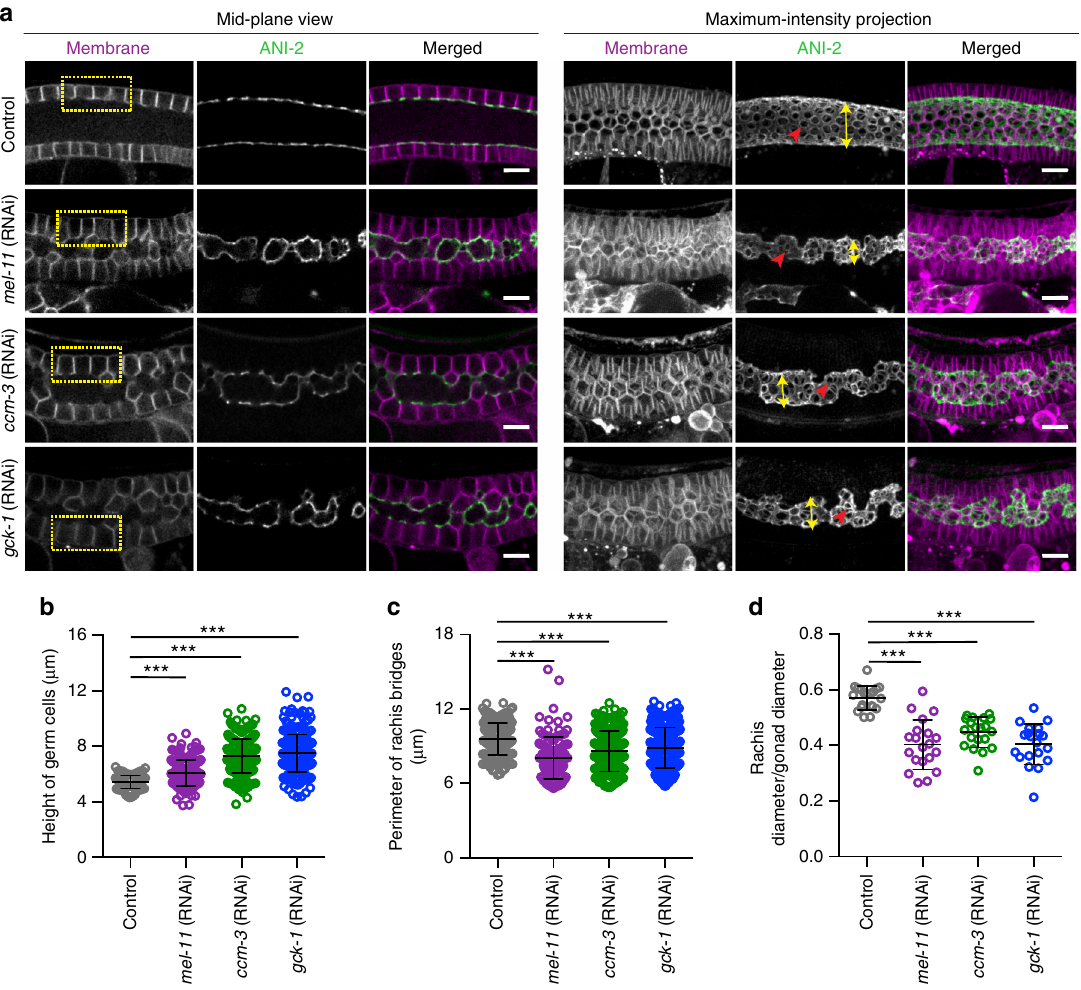
Fig. 4 Excessive contractility results in taller germ cells, and overly constricted intercellular bridges and rachis. a Mid-plane and maximum intensity projection views of control, mel-11(RNAi), ccm-3(RNAi) , and gck-1(RNAi) gonads expressing GFP::ANI-2 (green) and a membrane marker (magenta). Rectangular boxes (yellow) emphasize the increase in the height of germ cell membrane after knockdown. Red arrowheads highlight the difference in the perimeter of rachis bridges. Also the diameter of the rachis was reduced signi fi cantly in mel-11 (RNAi), ccm-3 (RNAi), and gck-1 (RNAi) gonads (yellow double-headed arrow). b Quanti fi cation of the height of germ cells in the early meiotic region of the gonads of control ( n = 102 membranes, N = 10 gonads), mel-11 (RNAi) ( n = 196 membranes, N = 20), ccm-3 (RNAi) ( n = 250 membranes, N = 25), and gck-1 (RNAi) ( n = 250 membrane, N = 25). c Quanti fi cation of the perimeter of rachis bridges in the early meiotic region of the gonads of control ( n = 187 bridges, N = 20), mel-11 (RNAi) ( n = 125 bridges, N = 16), ccm-3 (RNAi) ( n = 307 bridges, N = 23), and gck-1 (RNAi) ( n = 307 bridges, N = 21). d Quanti fi cation of rachis/gonad diameter in the early meiotic region of the gonads of control ( N = 20), mel-11 (RNAi) ( N = 20), ccm-3 (RNAi) ( N = 20), and gck-1 (RNAi) ( N = 20). Error bars denotes s.d. Data represent mean ± s.d. of three independent experiments. Statistical analysis was done using one-way ANOVA test (*** p < 0.0001). N = number of gonads analyzed. Scale bar, 10 µ